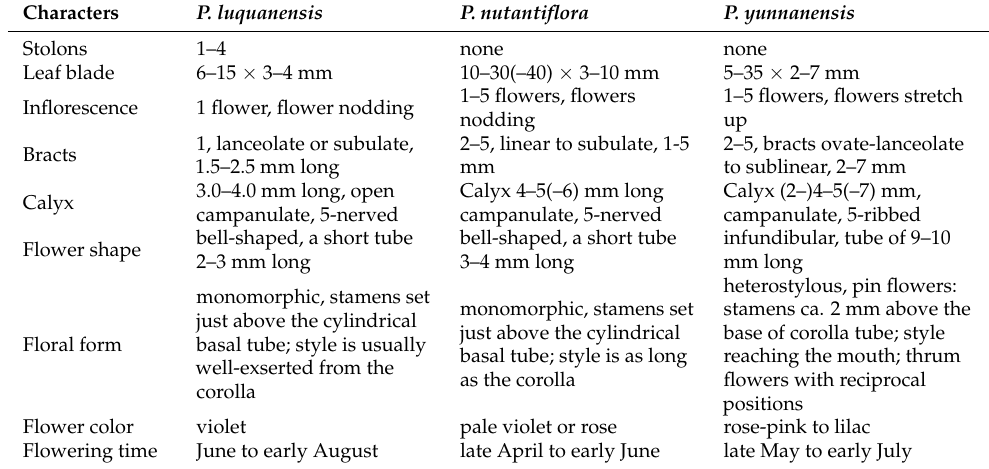
Table 1. Morphological and phenological comparison between Primula luquanensis , P. nutantiflora , and P. yunnanensis .